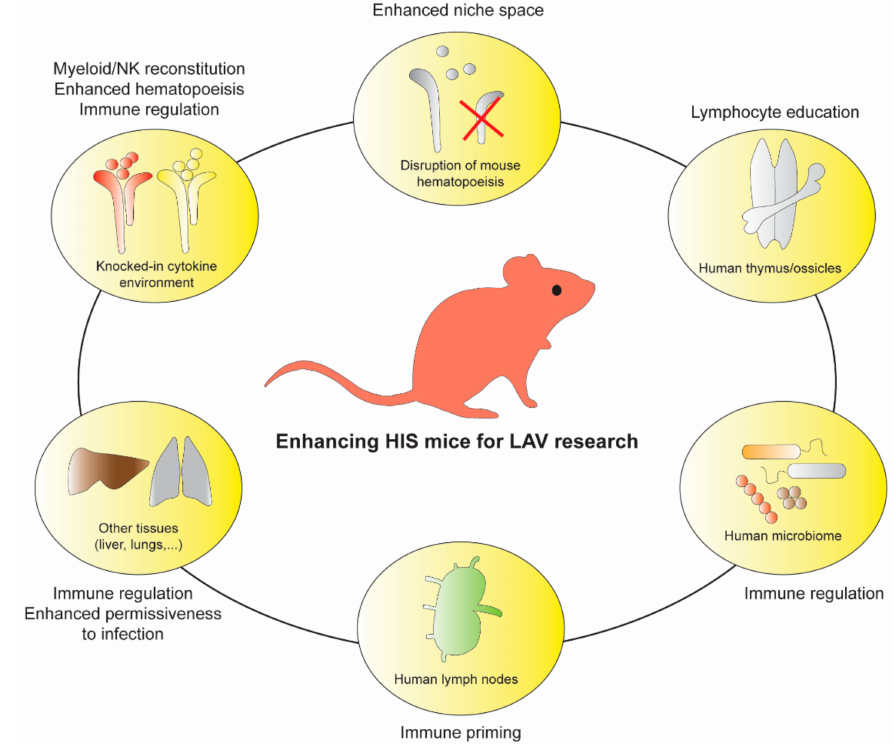
Figure 3. Enhancing human immune system mice for LAV research. Schematic representation